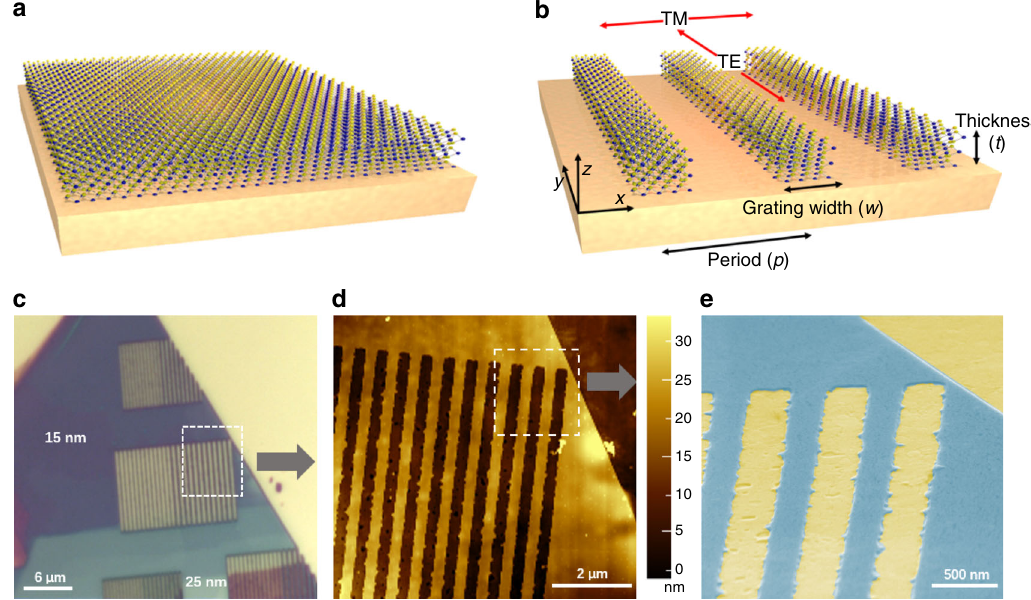
Fig. 2 Nanopatterned multi-layer WS 2 grating resonators on gold. a Schematic of an unpatterned multi-layer WS 2 fl ake on an Au substrate. b Schematic of a multi-layer WS 2 grating structure on a gold substrate. Red arrows denote the incident light polarization: TM polarization is de fi ned such that the electric fi eld is perpendicular to the grating, while the TE polarization electric fi eld is parallel to the grating. Grate width ( w ), period ( p ), and thickness ( t ) are de fi ned. c Unpolarized white light micrograph of WS 2 fl ake on Au substrate, showing patterned and unpatterned regions. Different colors appear due to different absorption spectra for different material thicknesses; 15 nm thick WS 2 exhibits a purple hue while 25 nm thick WS 2 appears pale blue. d Atomic force microscopy (AFM) image of the grating topography corresponding to dashed box of ( c ). e False color scanning electron microscopy (SEM) image of the boxed region in panel d acquired at 70° tilted angle. The grating structure with dimensions w = 300 nm and p = 600 nm is clearly